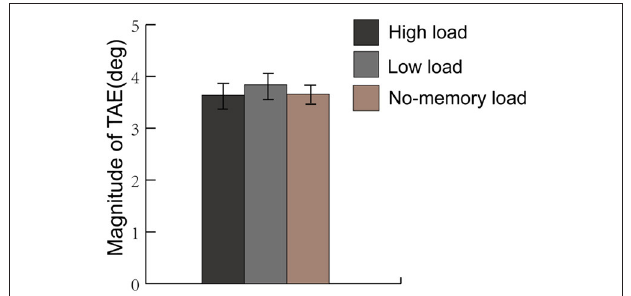
FIGURE 4 | The average magnitude of the TAEs under the low-load, high-load, and no-memory load condition in Experiment 2. No significant main effects between all three conditions on the magnitude of TAE was